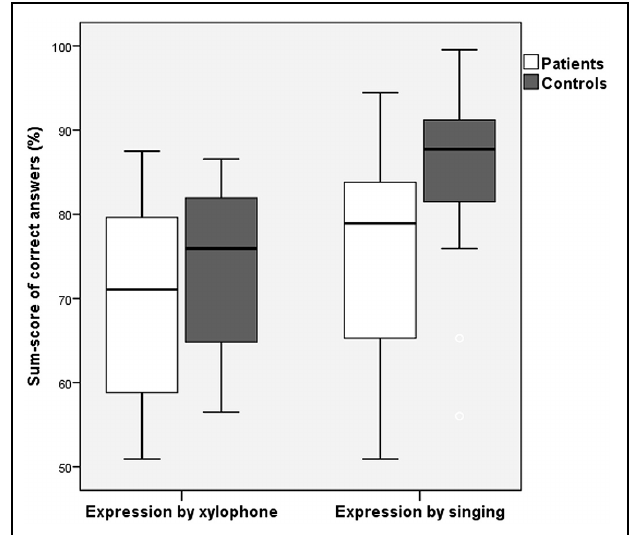
production by xylophone vs. singing (error bars indicate one standard